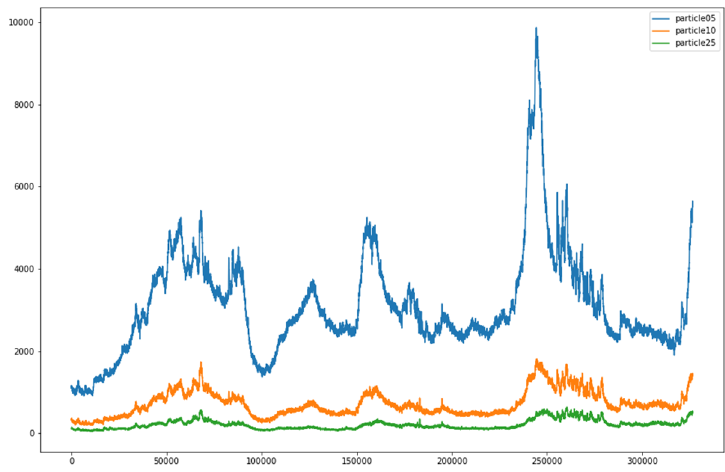
Figure 2. Our historical dataset collected from three PM values . Table 1. Descriptive statistics–particle ‐ matter measurement .